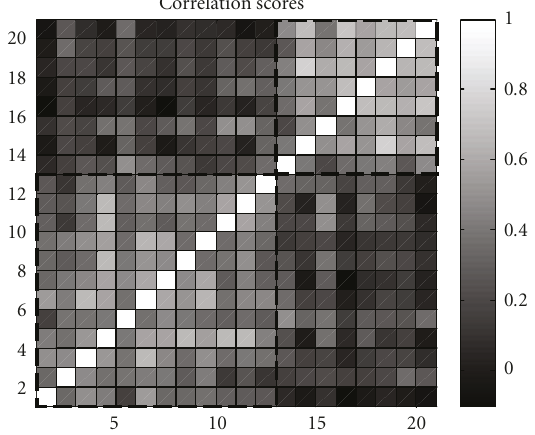
Figure 6: The autocorrelation of subjective scores shows a notice- able clustering of two groups of